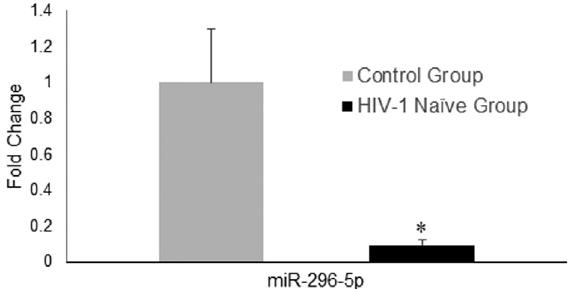
Figure 1 - MicroRNA-296-5p relative expression in plasma from healthy individuals and treatment-naïve HIV-1-positive patients. The expression was normalized with miR-200b-3p, miR-92a-3p, miR-193a-5p, and miR- 103a-3p. * Indicates statistically significant differences ( P < 0.05) by Mann-Whitney